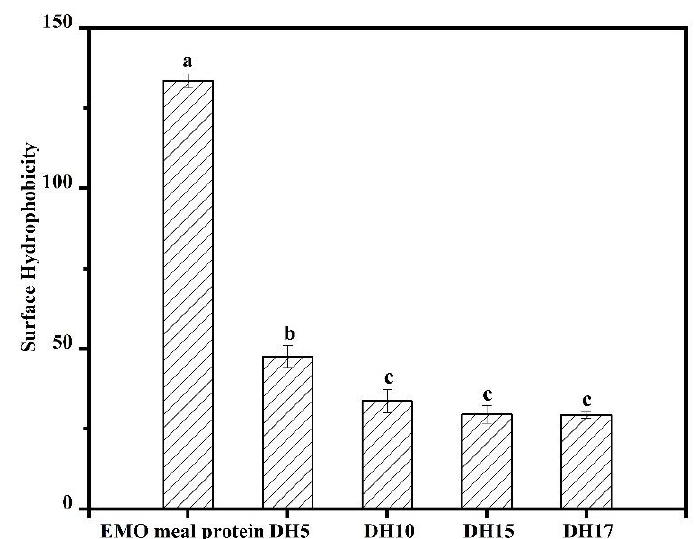
Figure 3. Changes in surface hydrophobicity of EMO meal protein and hydrolysates with different DH. The value of different superscript letters indicated significant difference ( p < 0.05).